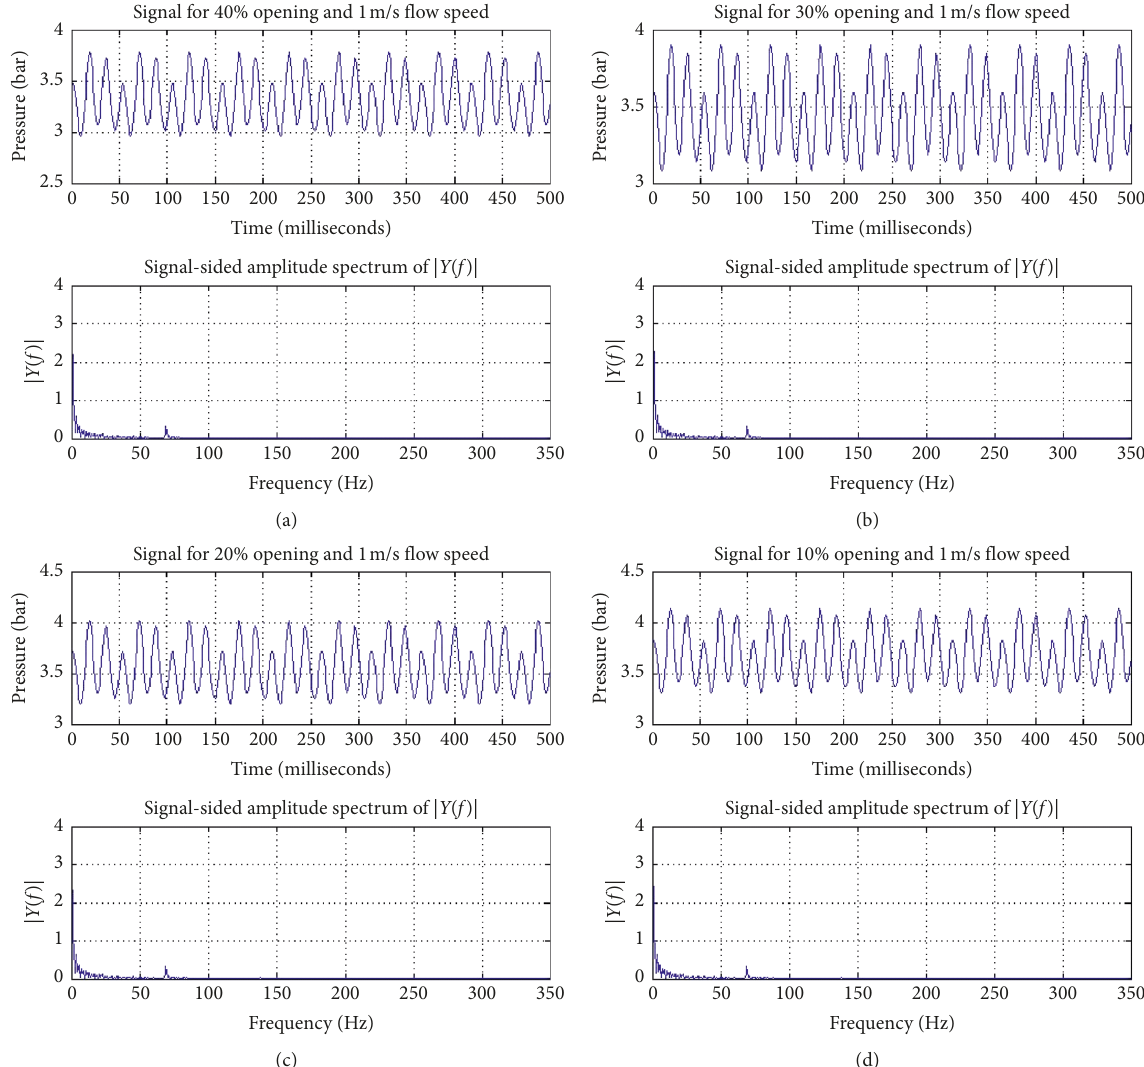
Figure 18: Pressure drop for flat face plug with flow velocity inlet 1m/s and different valve opening. (a) 10% valve opening; (b) 20% valve opening; (c) 30% valve opening; (d) 40% valve